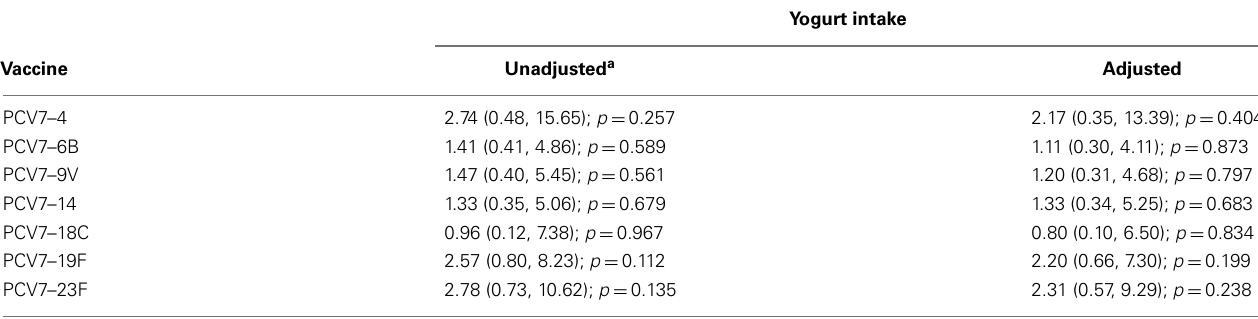
TableA3B | Summary of the PCV7 serotype-specific IgG responses ≥ 1.0 µ g/ml following adjustment for yogurt intake